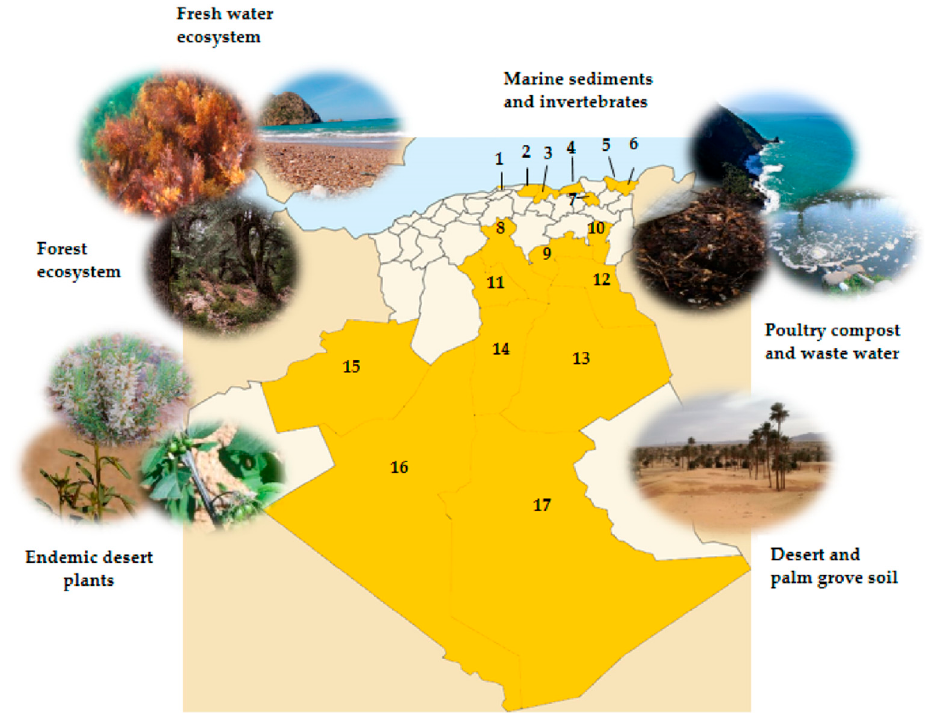
Figure 1. Distribution of the most explored Actinobacteria sampling sites in Algeria. 1 : Algiers, 2 : Tizi Ouzou, 3 : Bejaia, 4 : Jijel, 5 : Annaba, 6 : El Taref, 7 : Constantine, 8 : Djelfa, 9 : Biskra, 10 : Khenchela, 11 : Laghouat, 12 : El Oued, 13 : Ouargla, 14 : Ghardaia, 15 : Bechar, 16 : Adrar, and 17 : Tamarasset. Details are in Table 1.